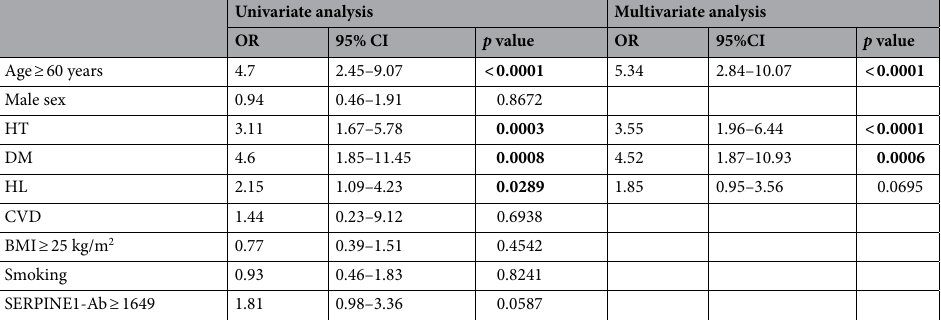
Table 4. Logistic regression analysis of the predictors of transient ischemic attack. The SERPINE1 antibody cutoff value of 1649 counts based on the ROC curve analysis for the TIA group was applied in the univariate analysis. Univariate data with p values of < 0.05 were included in the multivariate analysis. p values of < 0.05 are marked in bold. HT hypertension, DM diabetes mellitus, HL hyperlipidemia, CVD cardiovascular disease, BMI body mass index, OR odds ratio, CI confidence interval, Ab antibody.